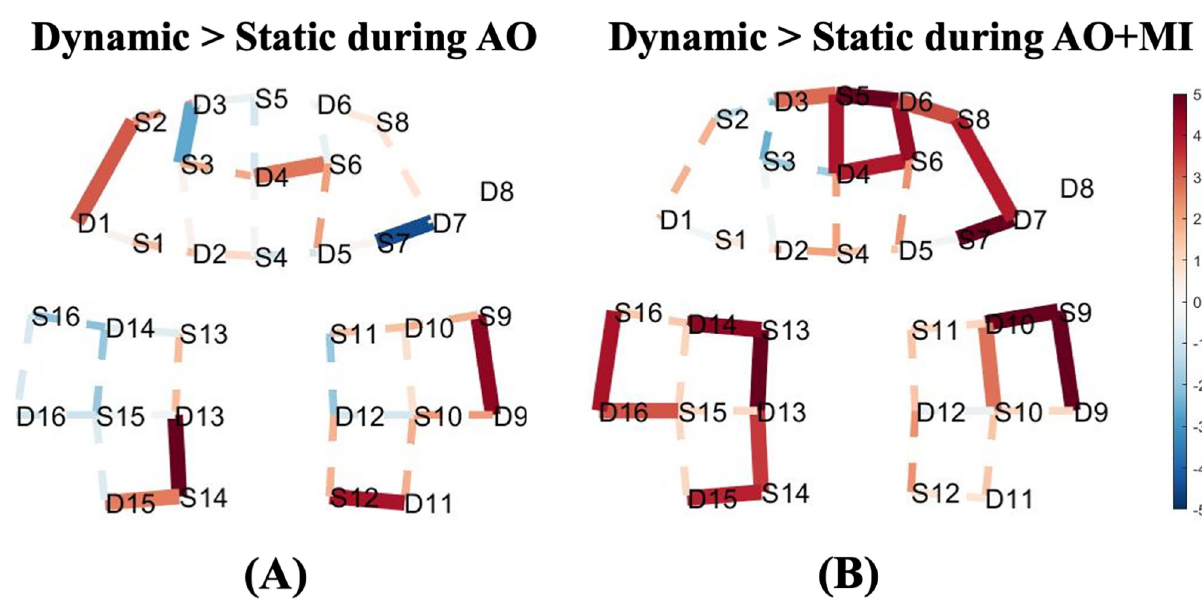
Fig 5. T-map of oxy-hemodynamic response (HbO) corresponding to the contrast between the dynamic standing and static standing balance tasks for (A) action observation experiment, and (B) a combination of motor imagery and action observation experiment. Significantly activated channels at p < 0.05 (FDR corrected) are indicated by thick, solid lines, red colour indicates stronger activity from the dynamic standing task than the static standing task. The dashed line shows the channels that were not statistically significant. This map was generated by using NIRS Brain AnalyzIR Toolbox [51]. Fig 2 illustrates the referencing for the brain regions with 10–20 EEG system positions.